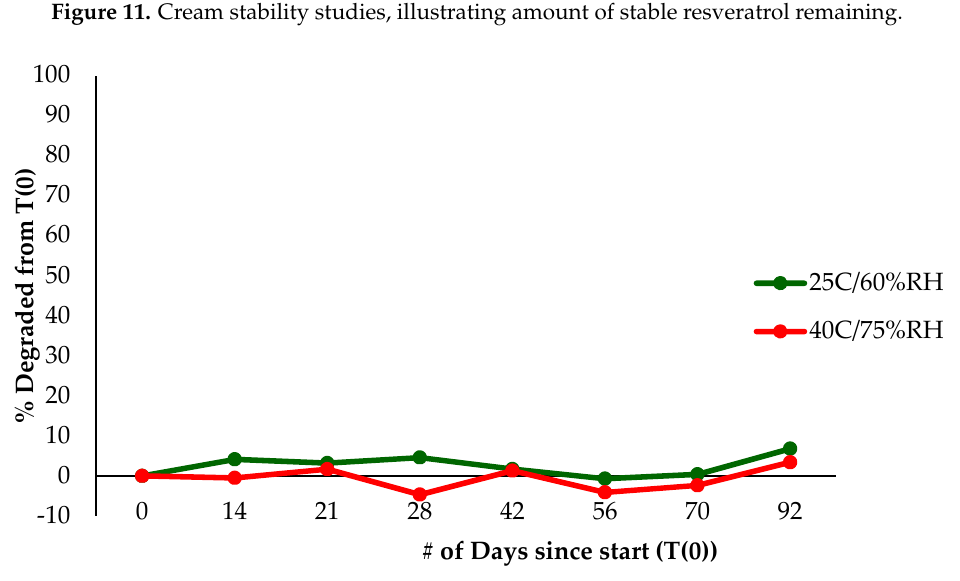
Figure 12. Cream stability studies, illustrating amount of degraded resveratrol over time in % degraded from starting time point.